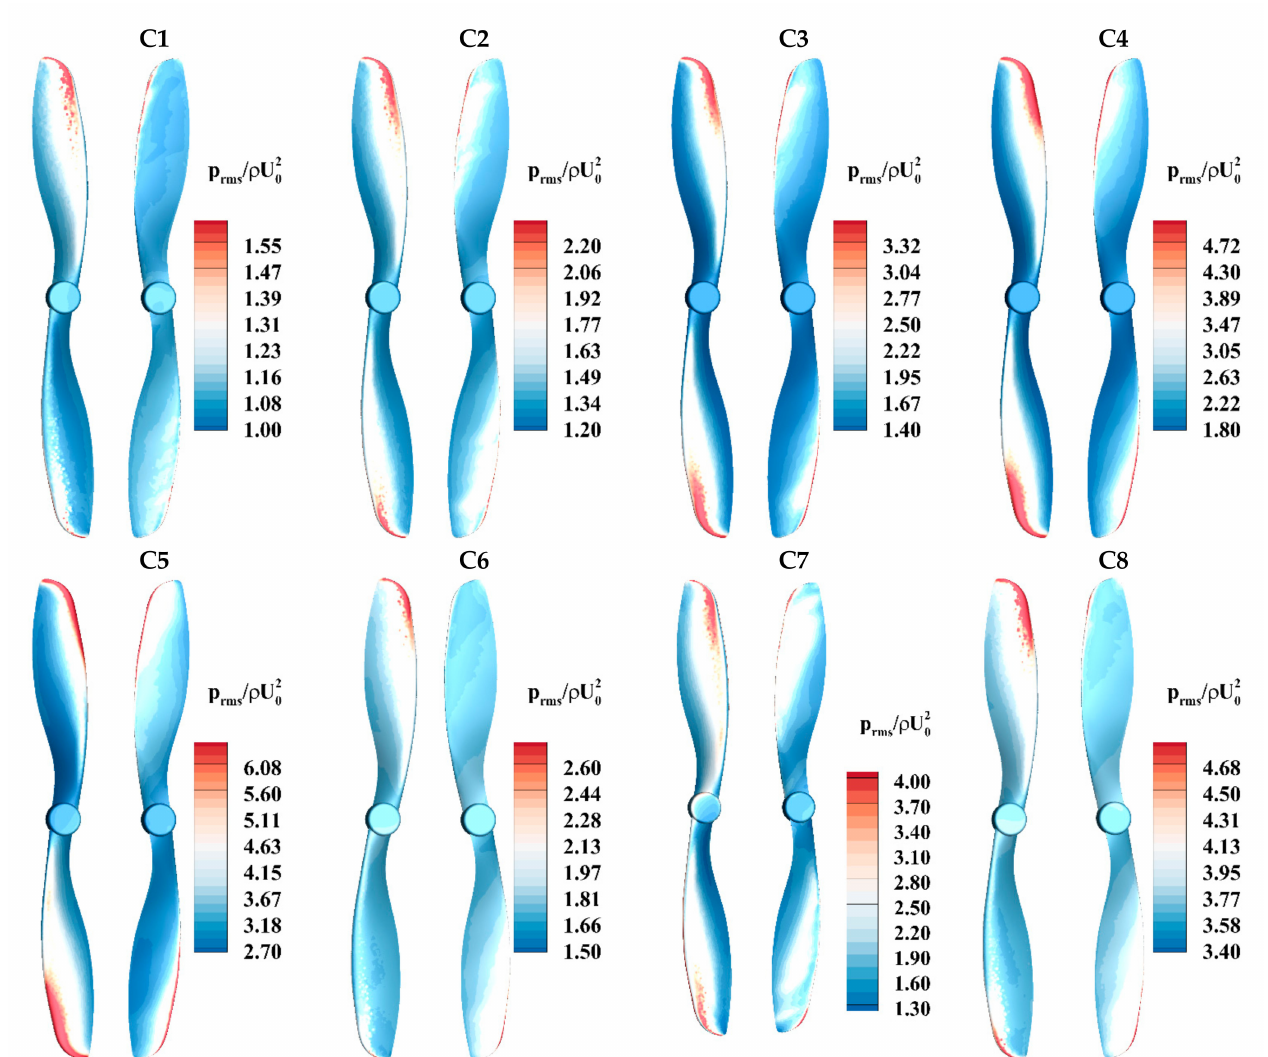
Figure 16. Dimensionless P RMS contour on propeller-3 of CRC-3 for various cases: C1 (RPM = 6000, U 0 = 7 m/s, θ = 0), C2 (RPM = 6000, U 0 = 7 m/s, θ = 15), C3 (RPM = 6000, U 0 = 7 m/s, θ = 35), C4 (RPM = 6000, U 0 = 7 m/s, θ = 55), C5 (RPM = 6000, U 0 = 7 m/s, θ = 75), C6 (RPM = 6000, U 0 = 4 m/s, θ = 15), C7 (RPM = 6000, U 0 = 13 m/s, θ = 15), C8 (RPM = 12,000, U 0 = 7 m/s, θ =